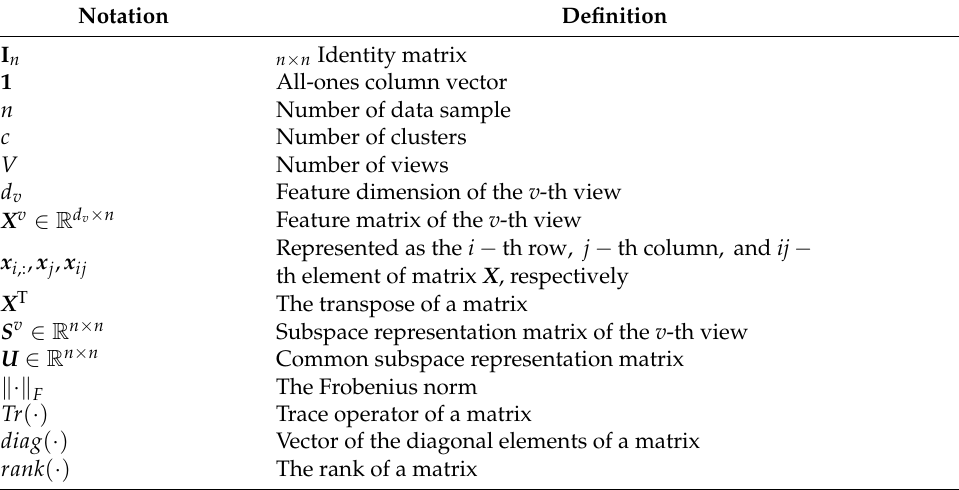
Table 1. Notations and